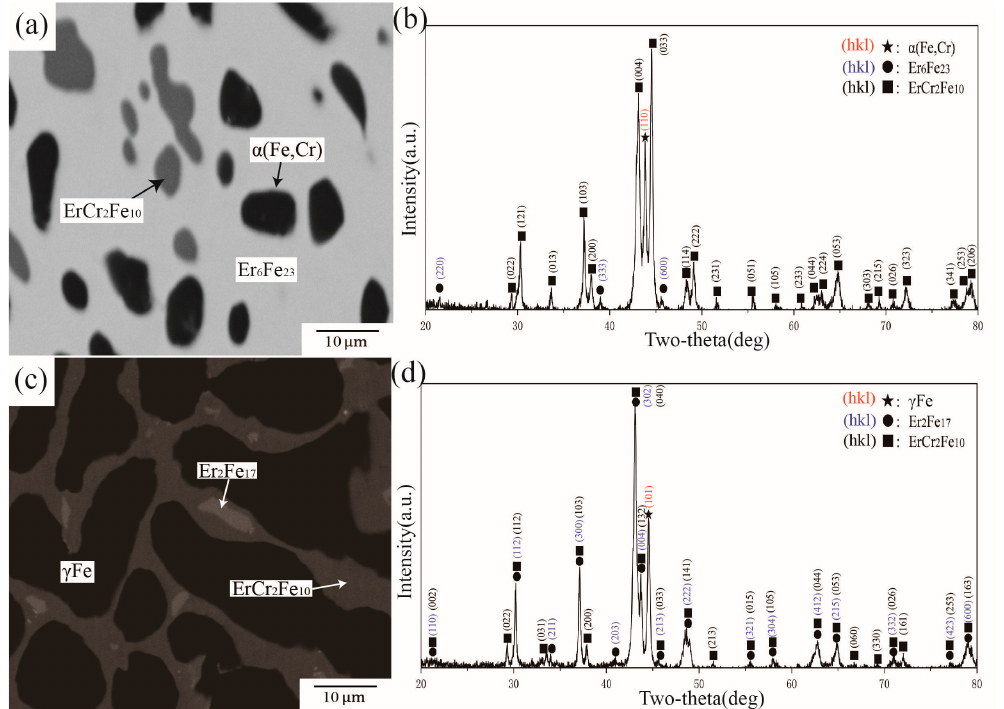
Figure 10. ( a ) BSE image of alloy A13, ( b ) XRD result of alloy A13, ( c ) BSE image of alloy A16, ( d ) XRD result of alloy A16.